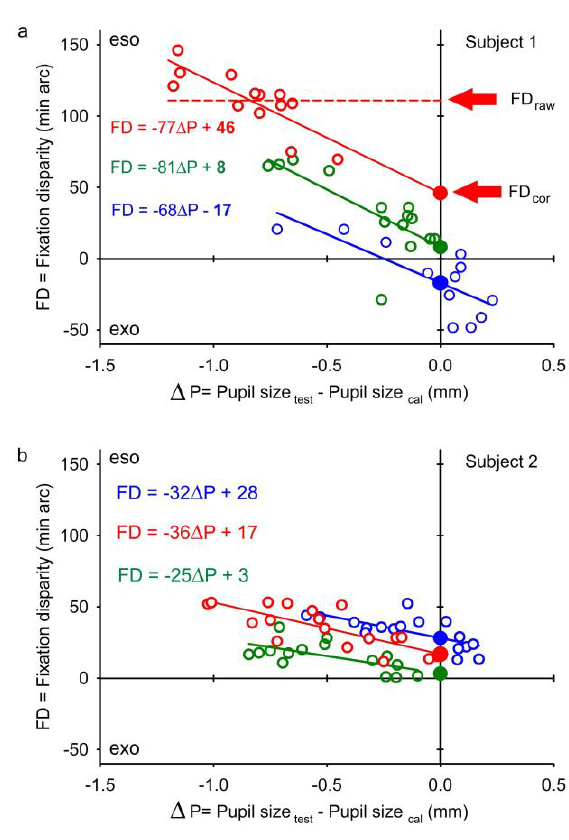
Figure 4: For two subjects, the measured fixation disparity in three exemplary runs (out of 24 runs per subject) are plotted as a function of the ΔP = Ptest – mean (Pcal). ΔP = 0 represents a condition when the pupil has the same size during the test and during the calibration. See text for interpretation.